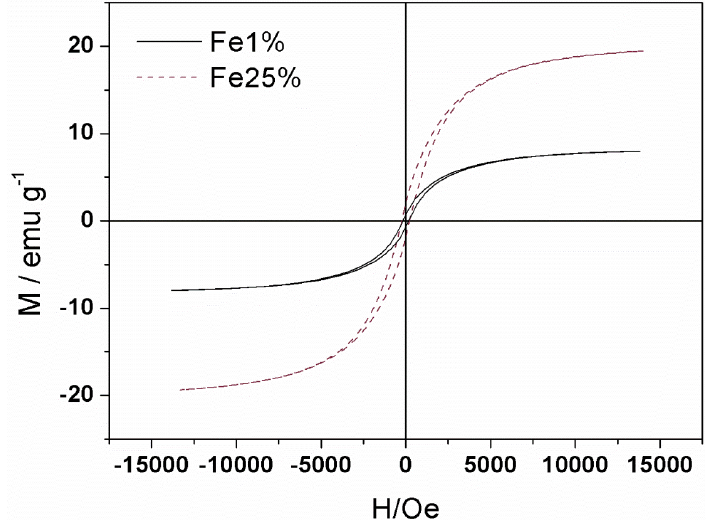
Figure 8. Magnetization curves of Fe1% and Fe25%, after CVD